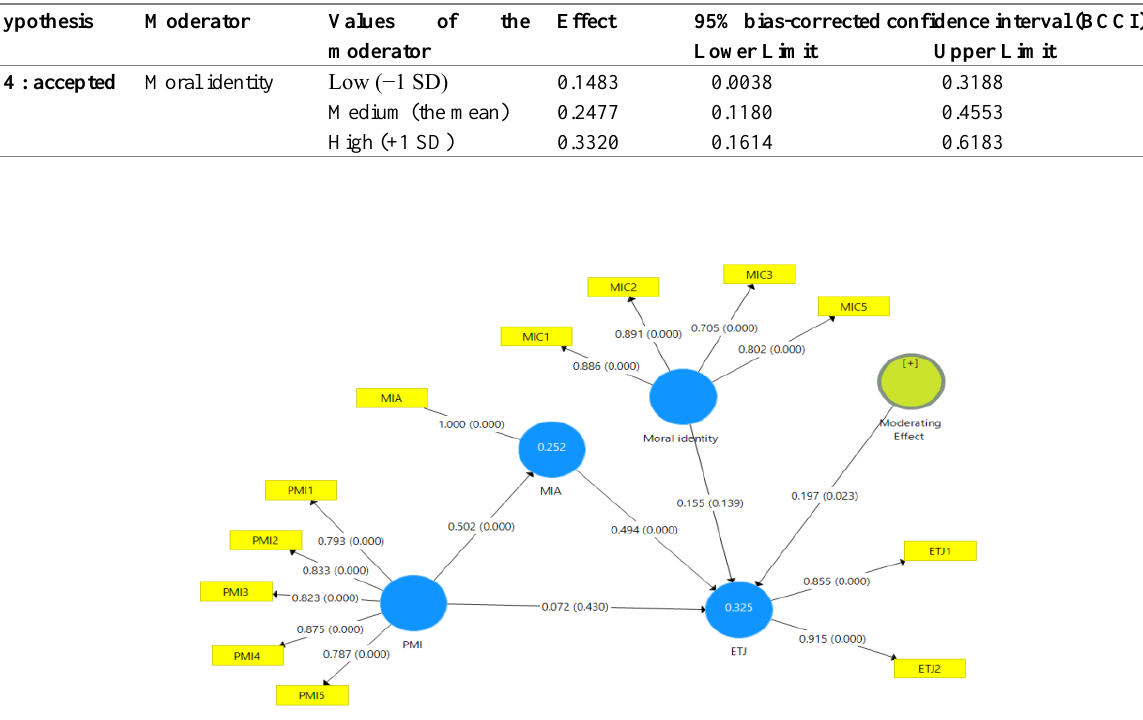
Figure 5: Model Results; Source: Smart Pls